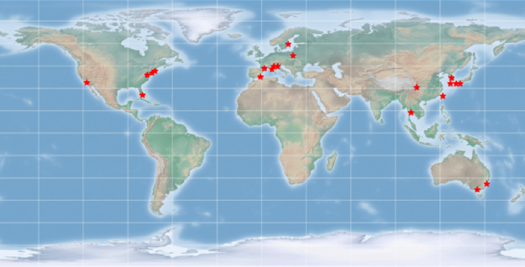
Figure 1. A map of countries with the symbol ★ for the first or corresponding authors of the accepted papers.